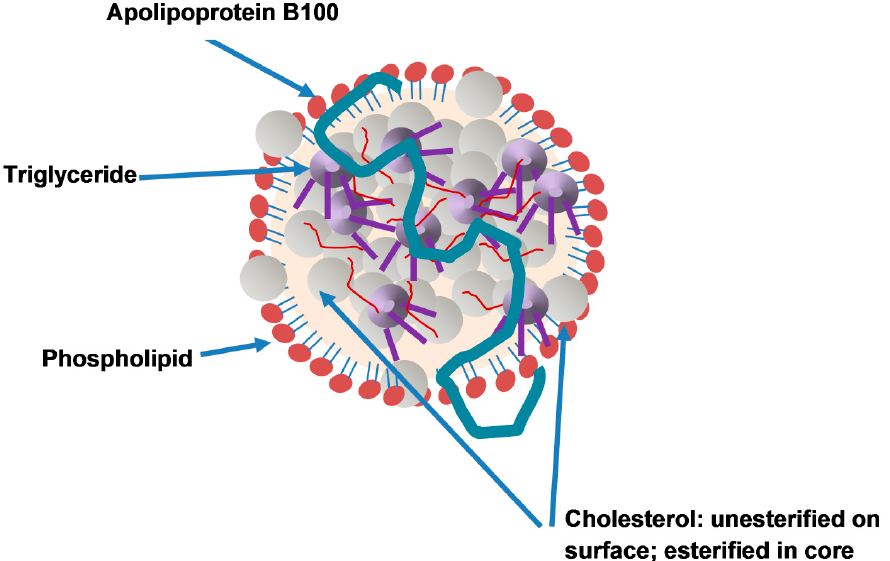
Figure 2. Apo B in a lipoprotein particle. A single molecule of apoB is irreversibly bound to the surface of the lipoprotein particle. The lipid content of the surface consists of a monolayer of phospholipid and free cholesterol. The hydrophobic core is composed of triglyceride and choles- terol esters.